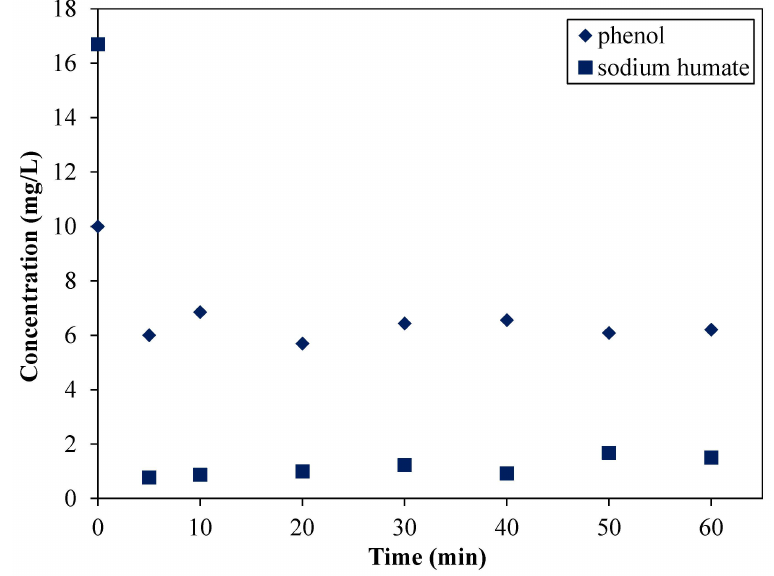
Figure 8. The effect of changing the input sequence—in this case, the following order was implemented